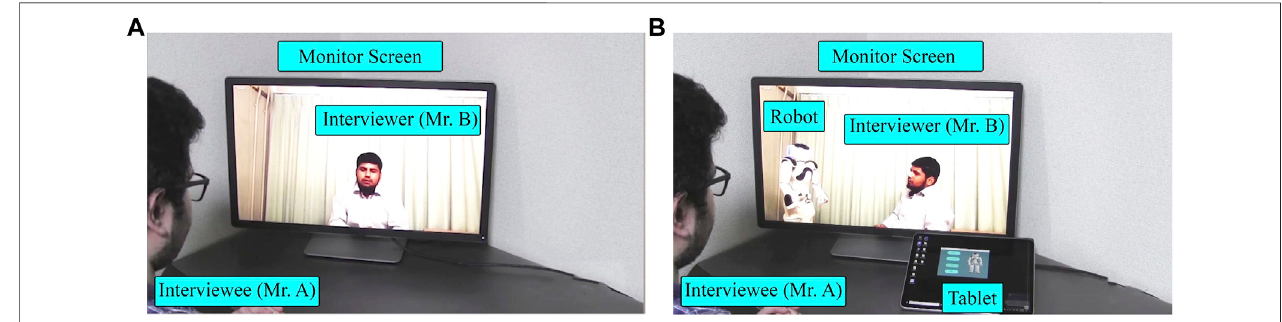
FIGURE 3 | Pictures from video stimuli of Experiment- Ⅰ : (A) Human condition (with interviewer ’ s gaze toward the interviewee.); (B) Robot condition (with interviewer ’ s gaze toward the robot avatar, controlled by the interviewee).